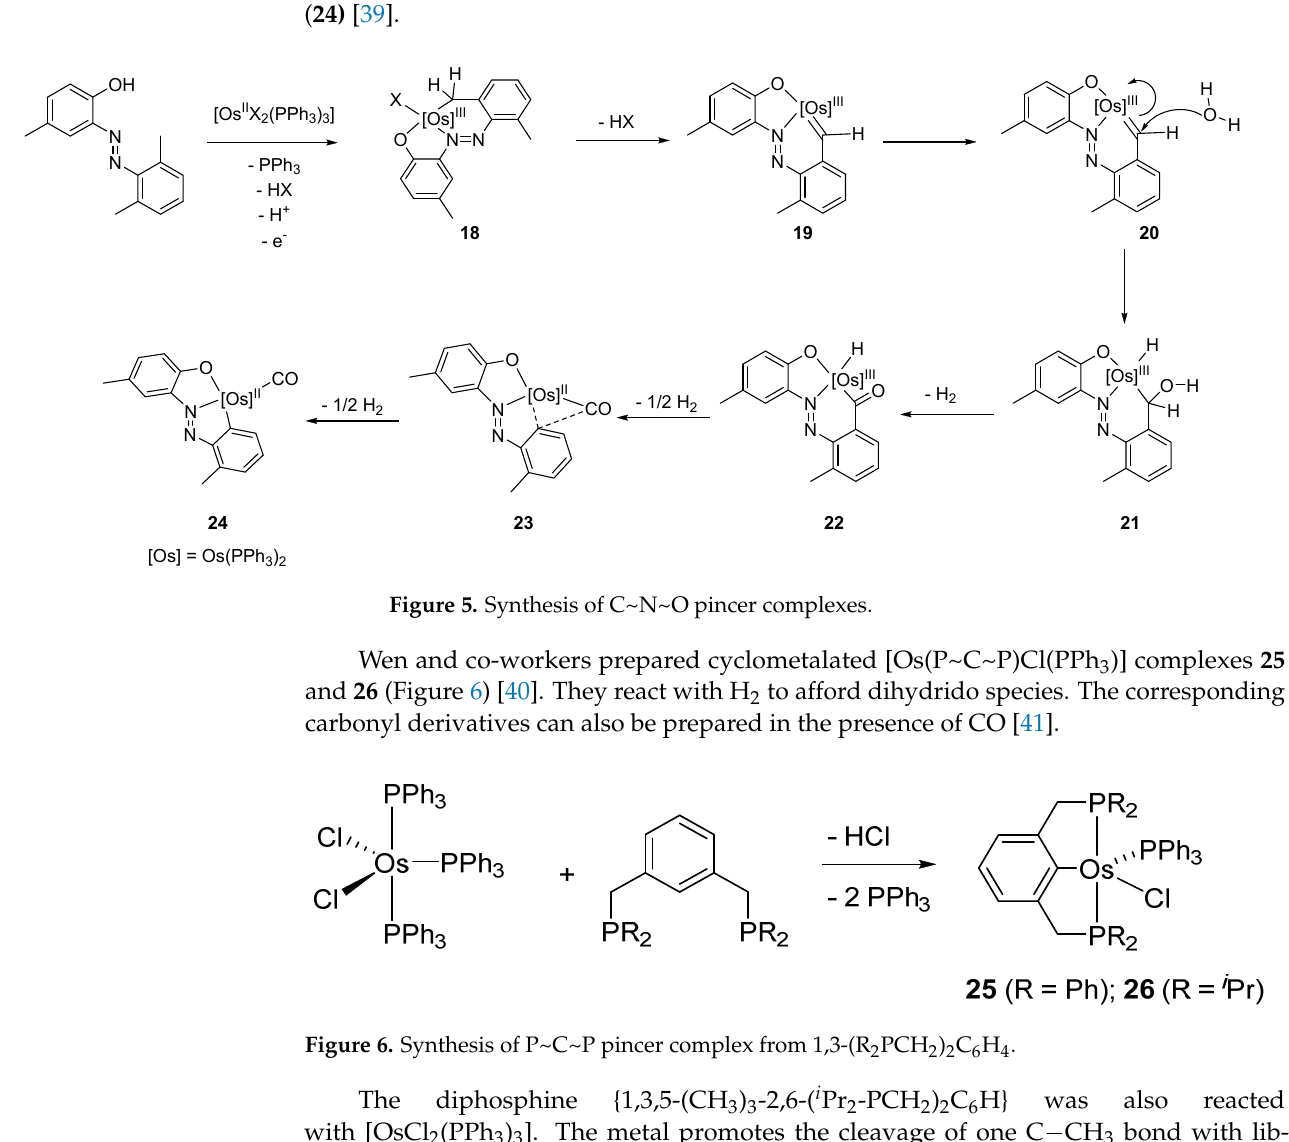
Figure 7. Synthesis of P~C~P pincer complexes by cleavage of a C-C bond. The